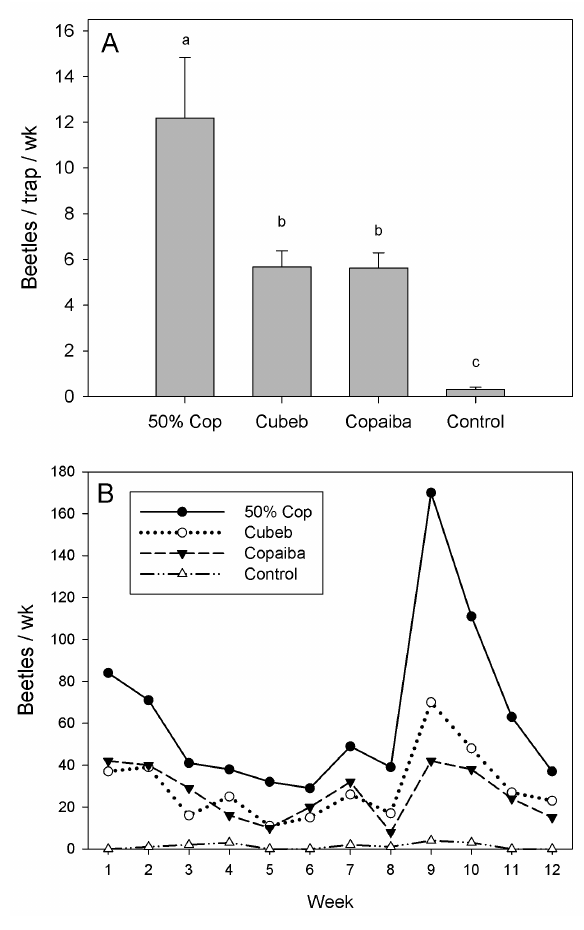
Figure 5: Captures of female Xyleborus glabratus in a 12-wk field test conducted in Highlands County, FL, USA. ( A ) Mean (± SE) captures and ( B ) summed weekly captures obtained with commercial cubeb oil lure, prototype copaiba oil lure, prototype 50% α-copaene lure (50% cop), and an unbaited control trap; N = 5 traps per treatment. Bars topped with the same letter are not significantly different; adapted from